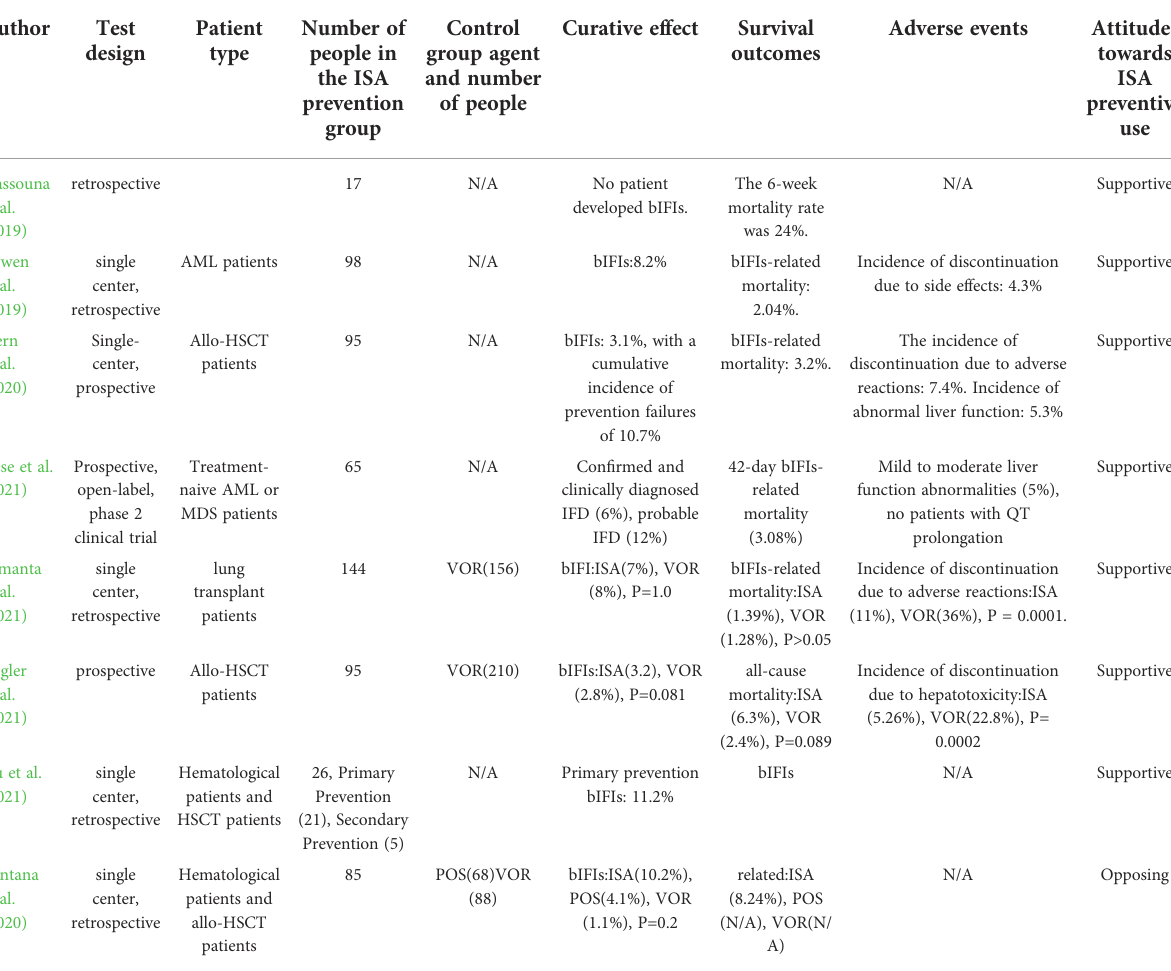
TABLE 2 Summary of ISA prophylactic antifungal